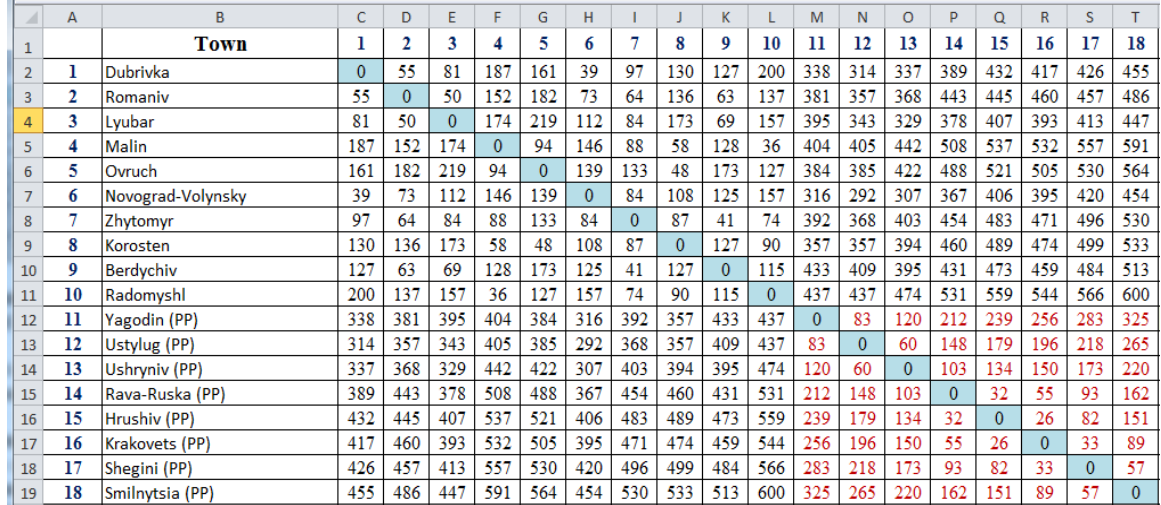
Figure 3: Distances between CPs, points of departure and destination in Microsoft Excel file